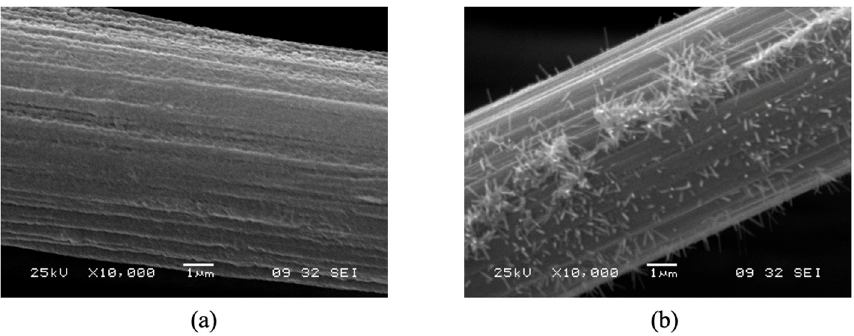
Figure 10. RuO 2 NRs grown on ( a ) commercially available Toray paper and ( b ) Toray paper with a thin thermally evaporated Ti (TiO 2 ) layer.